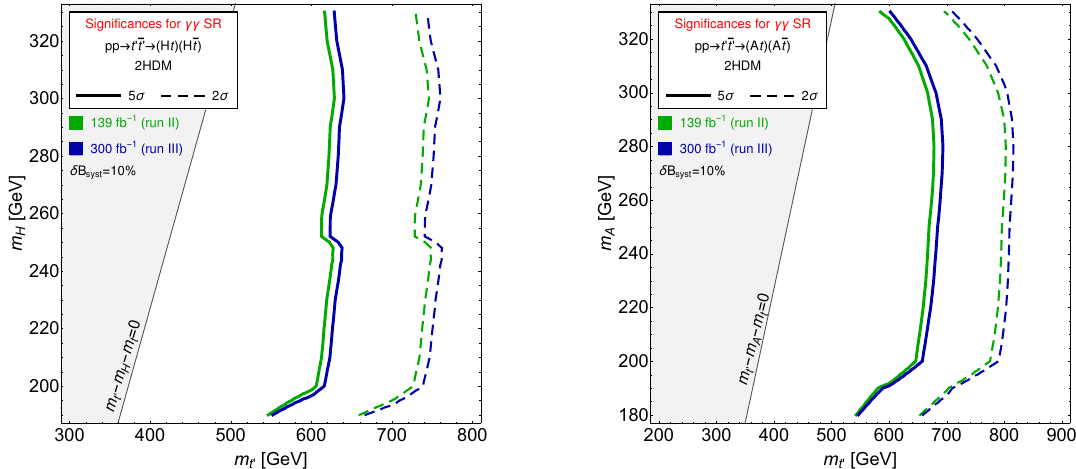
Figure 13 . Signi(cid:12)cances in the 2HDM+VLQ for points with large product of BRs of t H ! (cid:13) (cid:13) (left) or A ! (cid:13) (cid:13) (right). The meaning of the contours is the same as in (cid:12)gure